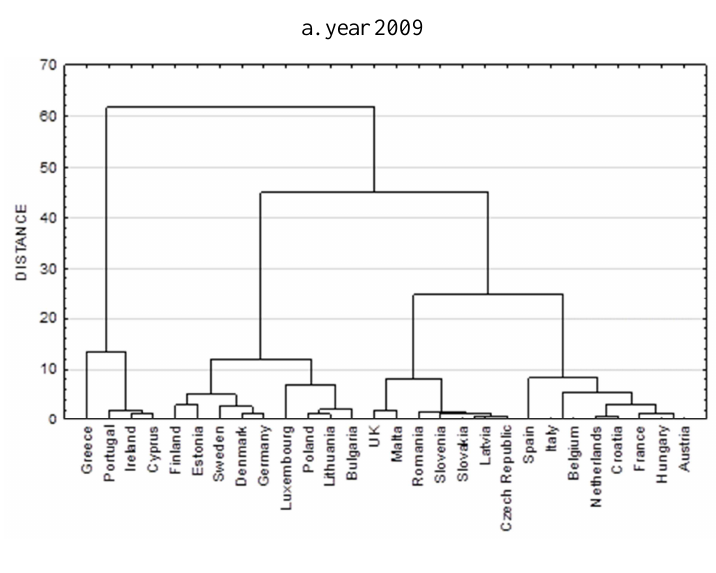
Figure 4. Dendograms for the years 2009 and